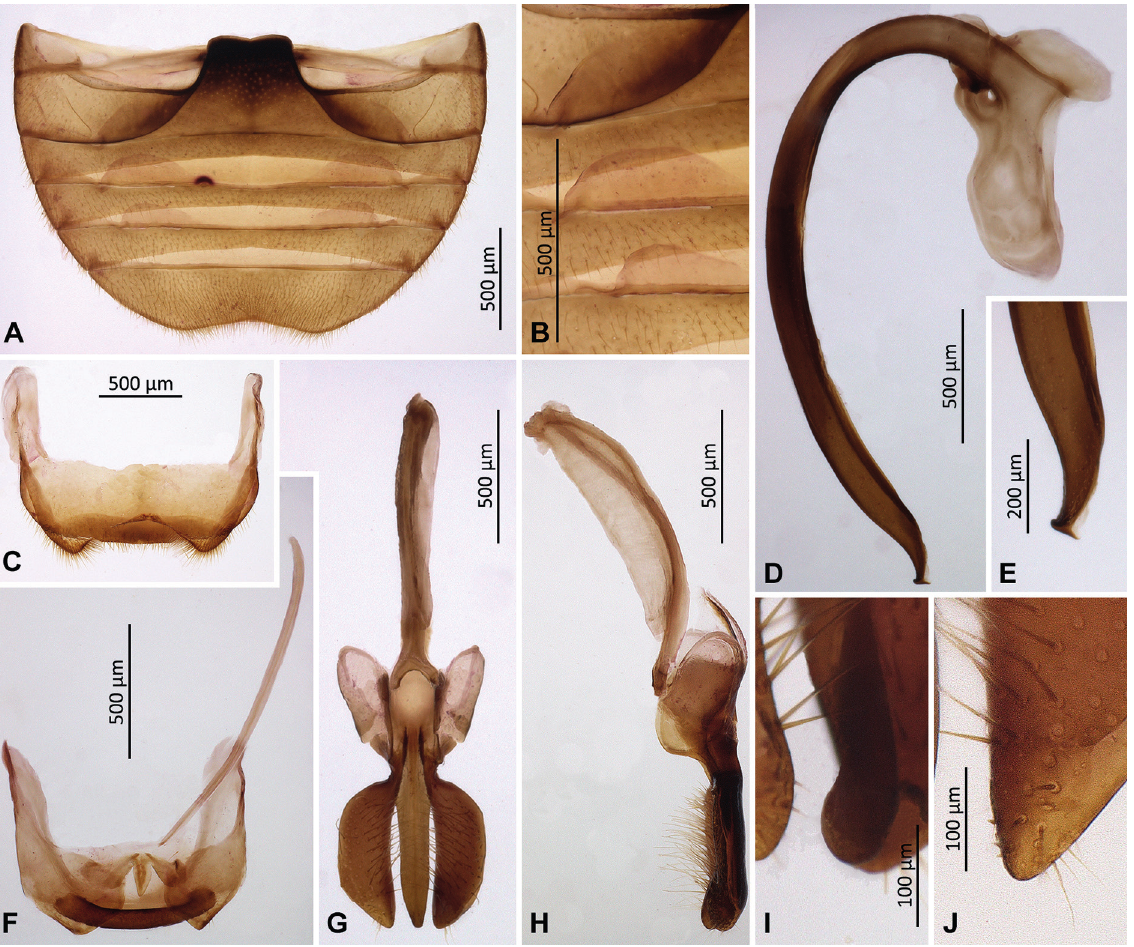
Fig. 8. Exoplectra misahualli sp. nov., ♂, holotype (MNHW). A . Abdomen. B . Inner surface of abdomen. C . Segment VIII, ventral view. D . Penis, lateral view. E . Penis tip, lateral view. F . Segments IX and X, dorsal view. G . Tegmen, inner view. H . Tegmen, lateral view. I . Penis guide apex, lateral view. J . Paramere apex, inner.